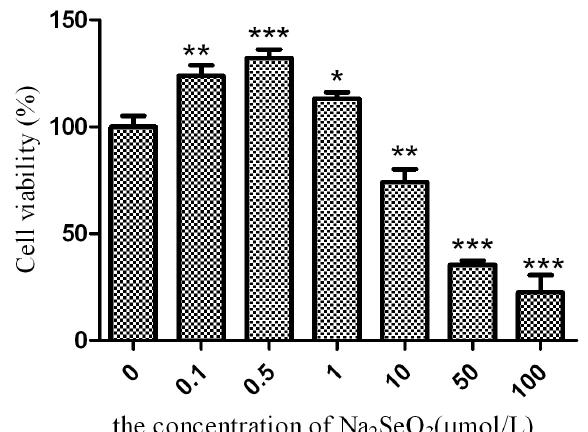
Figure 1. Dose-dependent effect of sodium selenite on the viability of HEK293T cells after 24 h treatment. ** p < 0.01 and *** p < 0.001, respectively, indicate significant and very significant differences between the selenite treated and the control